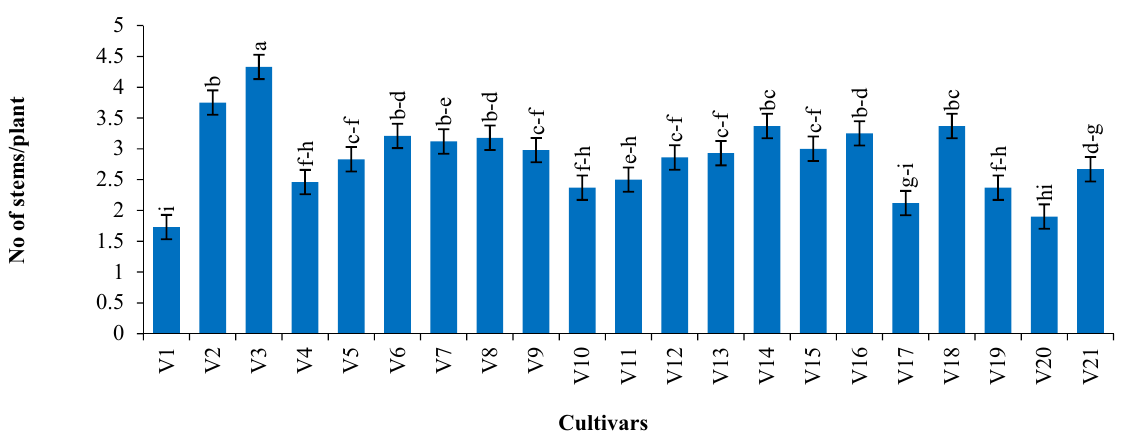
Figure 2. The number of stems/plants of different potato cultivars (two years pooled data); values with different lower case letters are significantly different between each other at the 5% level of significance ( p ≤ 0.05); vertical bars represent standard error of mean values. Table 1. Dry matter (DM) content in the shoot and the tuber bulking rate of various potato cultivars (Pooled data of 2 years).